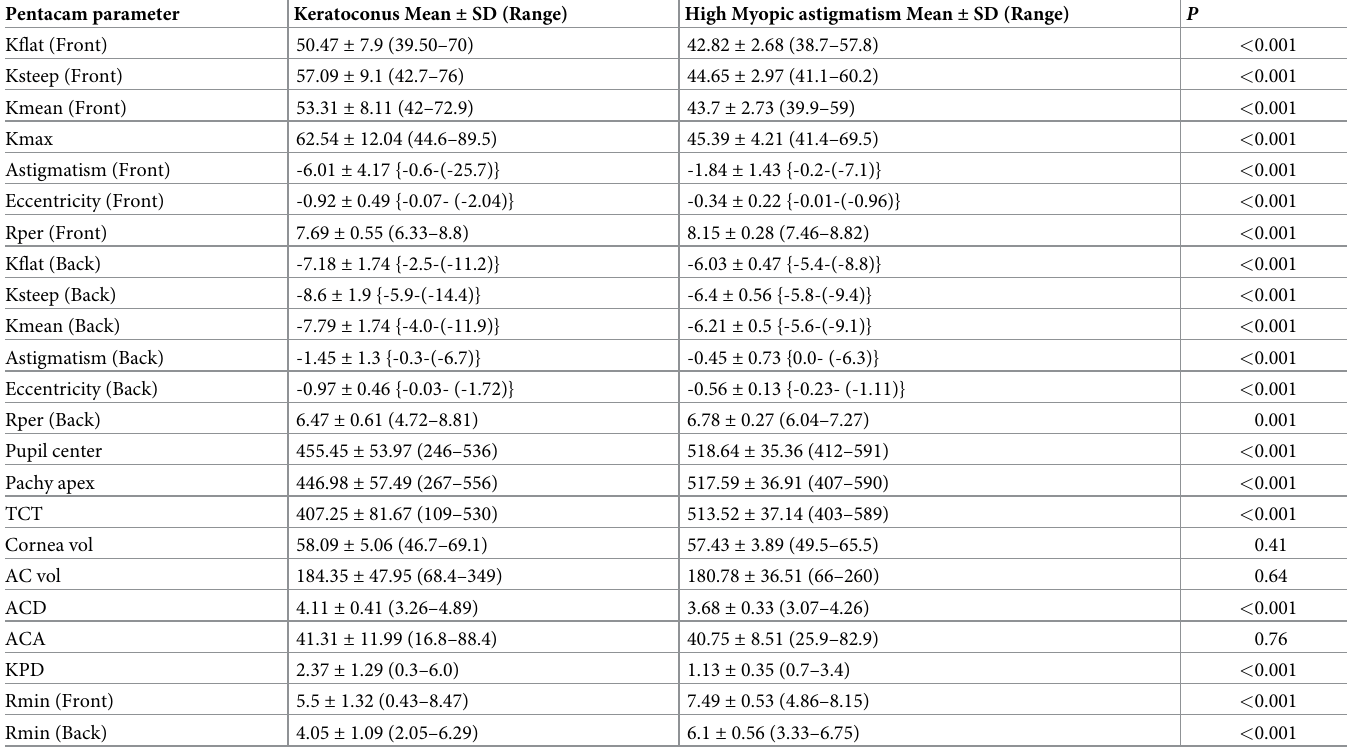
Table 1. Comparison of mean parameters of topographic maps between keratoconus and high myopic astigmatic eyes. Pentacam